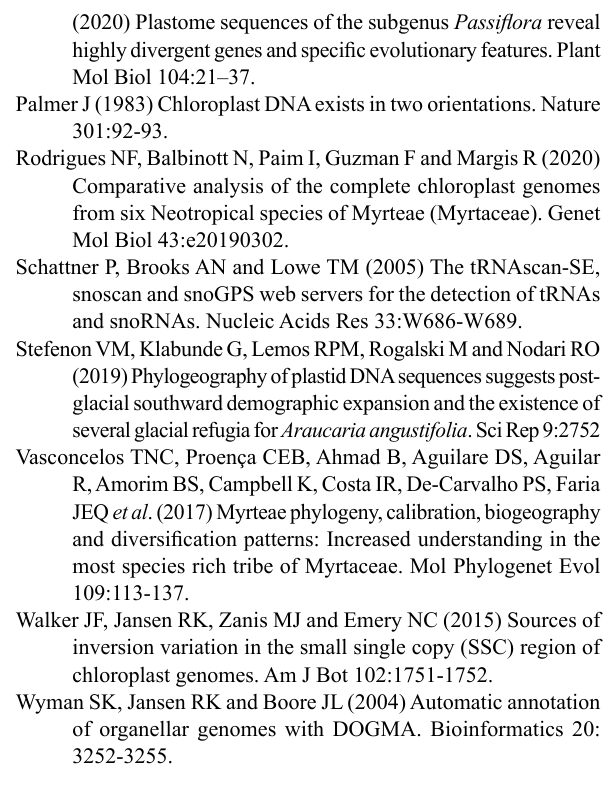
Figure S1 – (a) Distribution of the SSR loci within the plastid genome of P. phitrantha and P. cauliflora . Figure S2 – Boundaries at the junctions of the LSC, IRb, IRa, and SSC regions of the plastid genomes of South American Myrteae species. Figure S3 – Sliding window analysis of the plastid genomes of 15 Myrteae species. Figure S4 – Multiple plastid genome alignment with four Plinia species and R. tomentosa